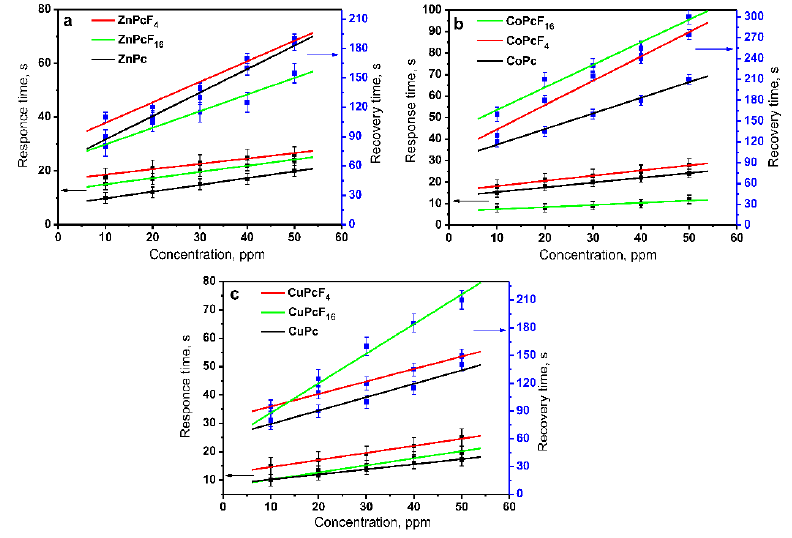
Figure 4. Dependence of the response and recovery times on NH 3 concentration (10–50 ppm) for ZnPcF x ( a ), CoPcF x ( b ), and CuPcF x ( c ) ( x = 0, 4, 16) Table 1. Average values of response and recovery times of MPc, MPcF 4 , and MPcF 16 films at the concentration of ammonia 10 ppm.